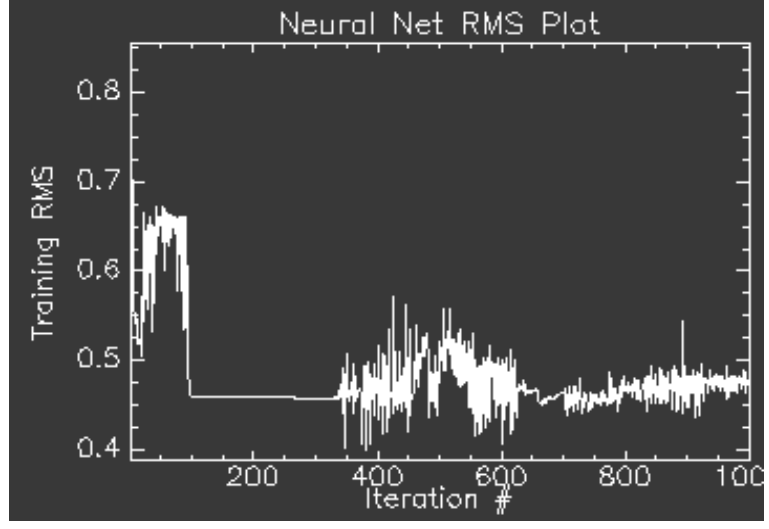
Figure 8. The RMSE vs. iterations for NN classification of the uncorrected image for a sample of Nicolet vegetation species training sets.